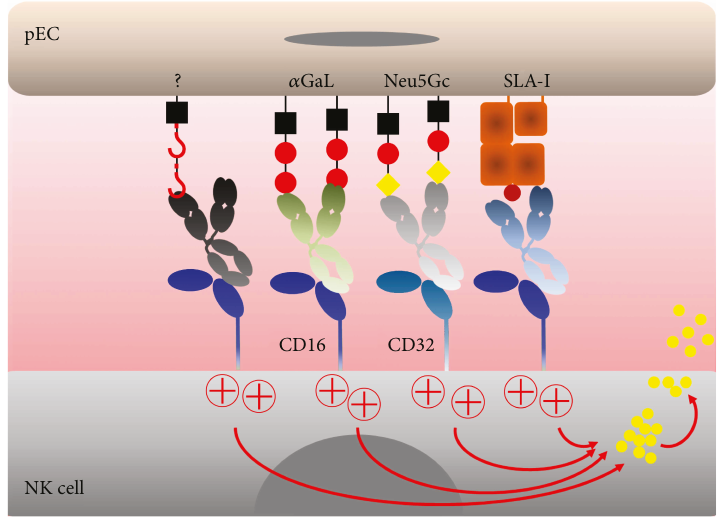
Figure 2: NK cell-mediated destruction of pig endothelial cells by recognition of human anti-pig antibodies (ADCC). Preformed natural XenoAbs circulating in the blood, mainly directed against α Gal but also other sugar antigens such as Neu5Gc, bind to pig endothelial cells with their Fab portion. The Fc-fractions of the antibodies are recognized by the FcRs located on the surface of NK cells, for instance, CD16 (Fc γ RIIIa) triggering the signaling cascade that leads to NK cell degranulation. The release of their lytic granules containing granzymes and perforin leads to target cell destruction, in this particular context, pig endothelial cells lysis, a process known as antibody-dependent cell-mediated cytotoxicity (ADCC). Alternatively, induced anti-SLA class I antibodies (far right) are recognized by NK cells via CD16, also leading to ADCC. α Gal: alpha Gal xenoantigen; HD Ag: Hanganutziu-Deicher antigen; Neu5Gc, SLA-I: swine leukocyte antigen class